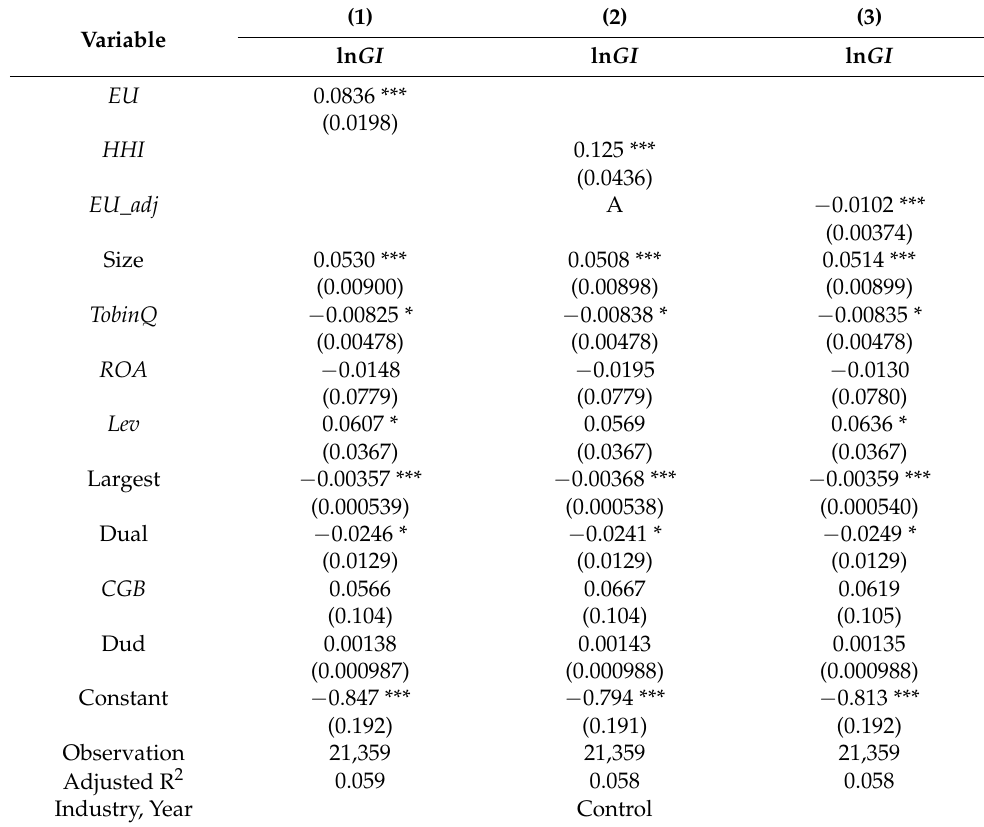
Table 5. Regression analysis of environmental uncertainty and enterprises’ green technological